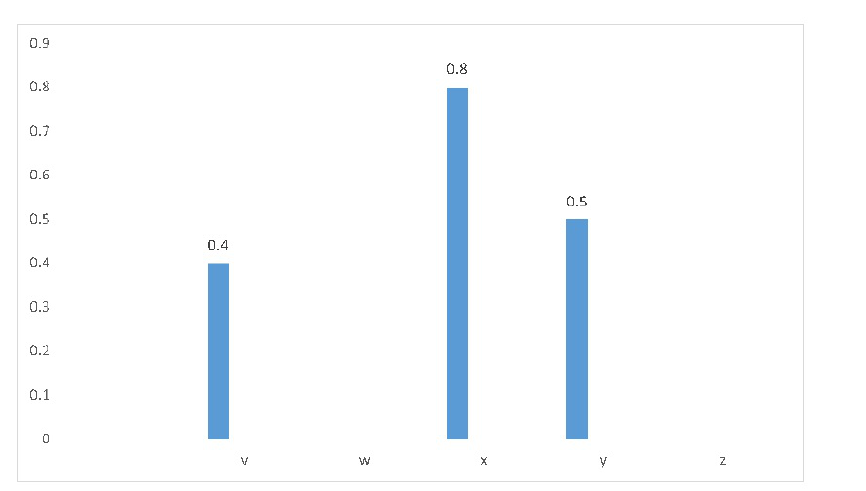
Figure 1. Graph of fuzzy set.